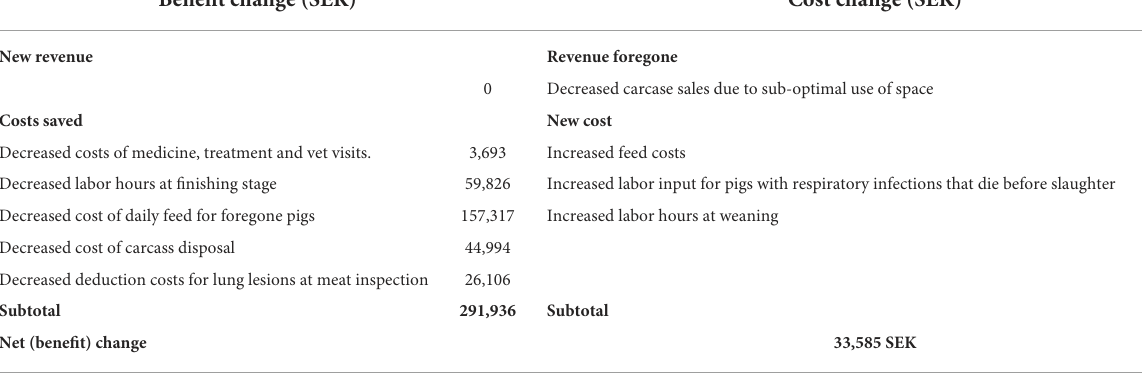
TABLE 6 Deterministic effects on net benefit change of adopting strategy S1 (avoiding mixing litters).